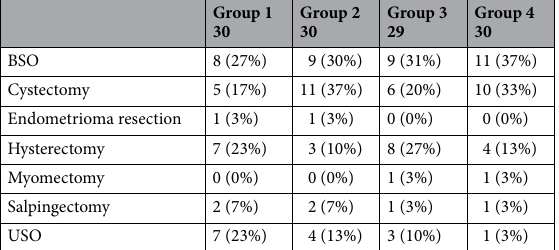
Table 2. Surgery type according to study group. BSO: Bilateral salpingo-oophorectomy. USO: Unilateral salpingo-oophorectomy.